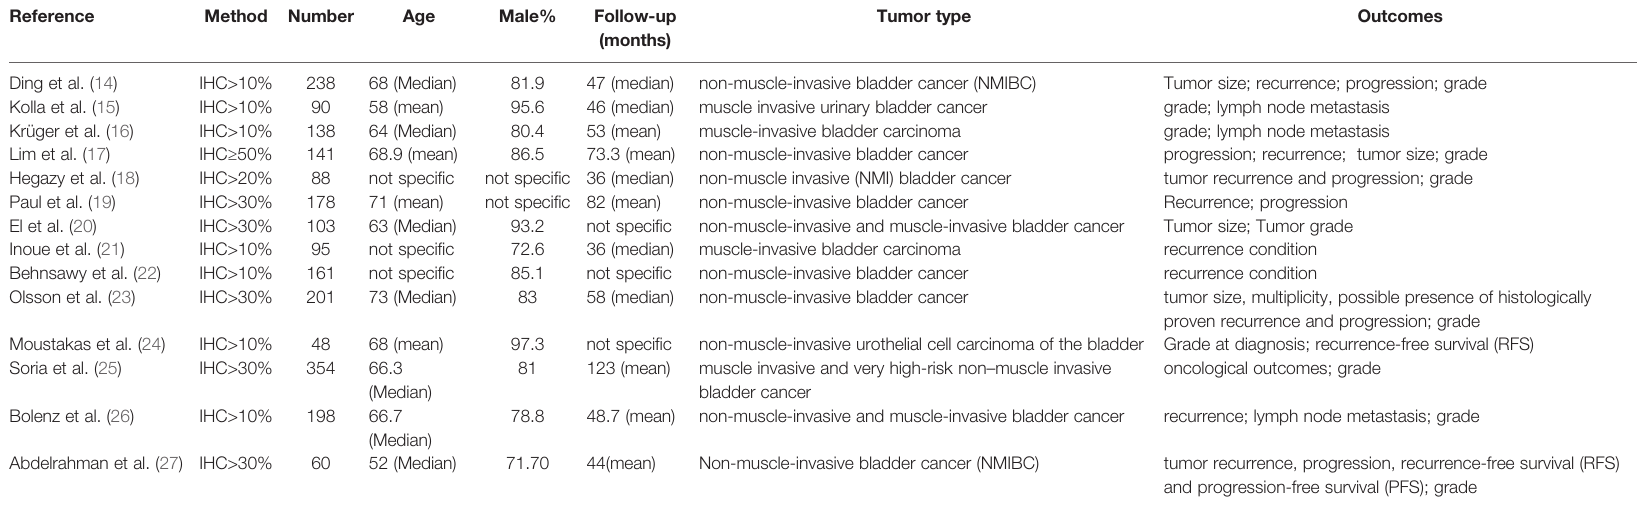
TABLE 1 | Extracted data of included studies.